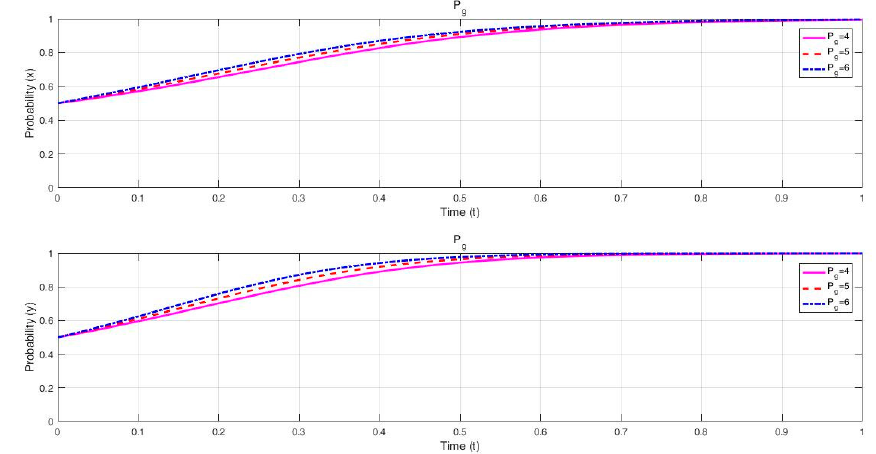
Figure 9. The impact of P g on the game.